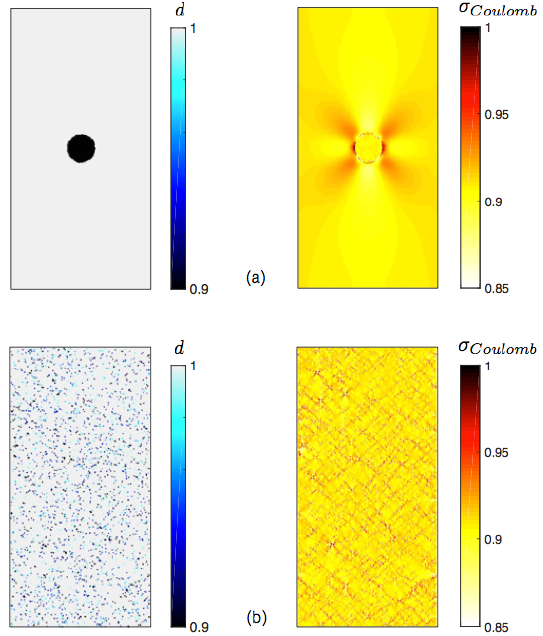
Figure 6. Coulomb’s stress field (the normalized maximum stress with respect to the Mohr–Coulomb damage criterion) generated by (a) a circular inclusion defined on the initial field of the level of damage ( d = 0 . 9) in an otherwise undamaged ( d = 1), homo- geneous and linear-elastic material (left) and (b) by local damage events within an initially undamaged material in which disorder is introduced locally in the damage criterion via the field of cohesion, C . In both cases, the spatial resolution is N = 80 and the plate is subjected to the same uniaxial compression and boundary condi- tions as described in Sect. 5 and Fig.